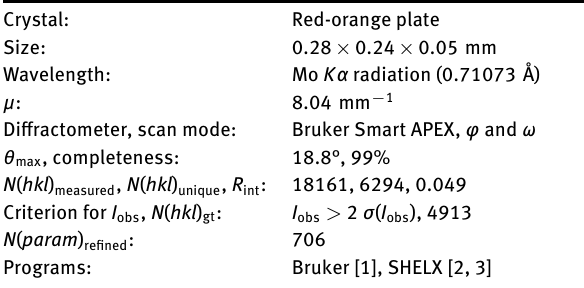
Table 1 contains crystallographic data and Table 2 contains the list of the atoms including atomic coordinates and dis- placement parameters. Table 1: Data collection and